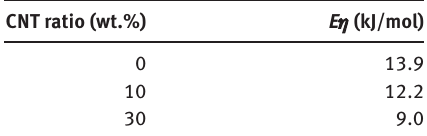
Table 1 Effect of CNT ratio on viscous flow activation energy ( E η